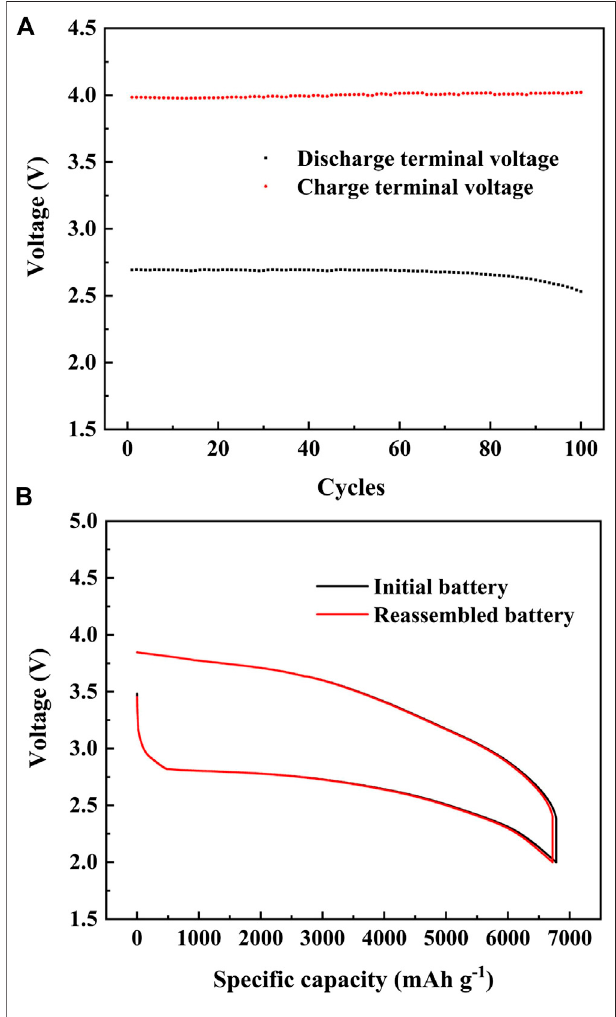
FIGURE 6 | (A) Cycle performance of the Cr 2 O 3 /MnO 2-x cathode electrode under the current density of 400 mA · g − 1 with the fi xed capacity of 1,000 mAh · g − 1 ; (B) Discharge-charge performance of the reassembled battery and the initial